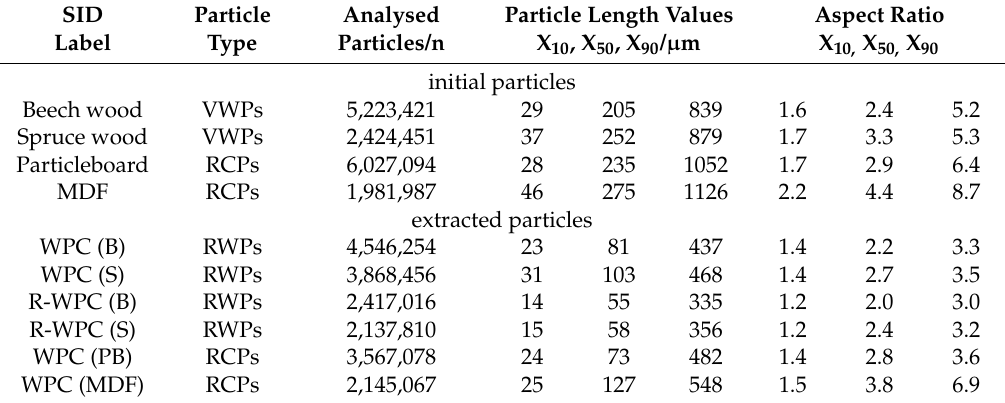
Table 2. Length and aspect ratio of particles for the X 10 , X 50 , X 90 quantiles in dependence on used material source. The results are presented for the particles before (initial) and after processing (extracted) . SID: sample identification. Particle type: VWPs (virgin wood particles), RWPs (reprocessed WPC particles), RCPs (recycled composite